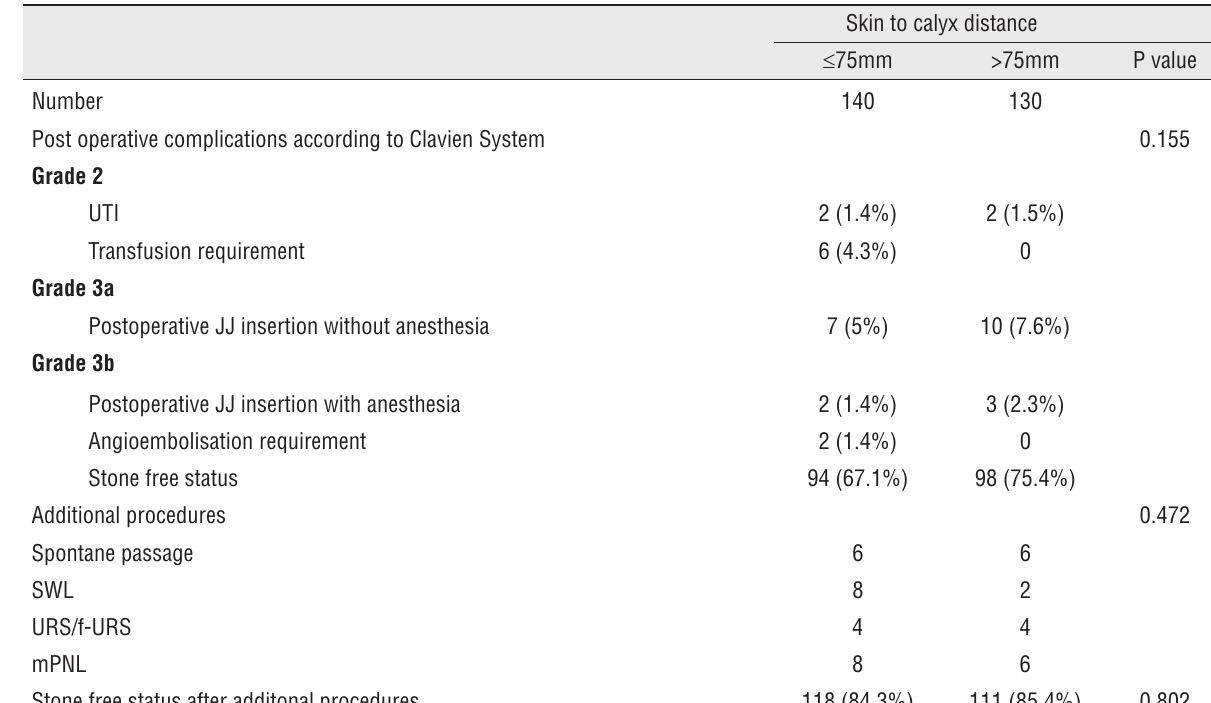
Table 3 - comparison of postoperative results and